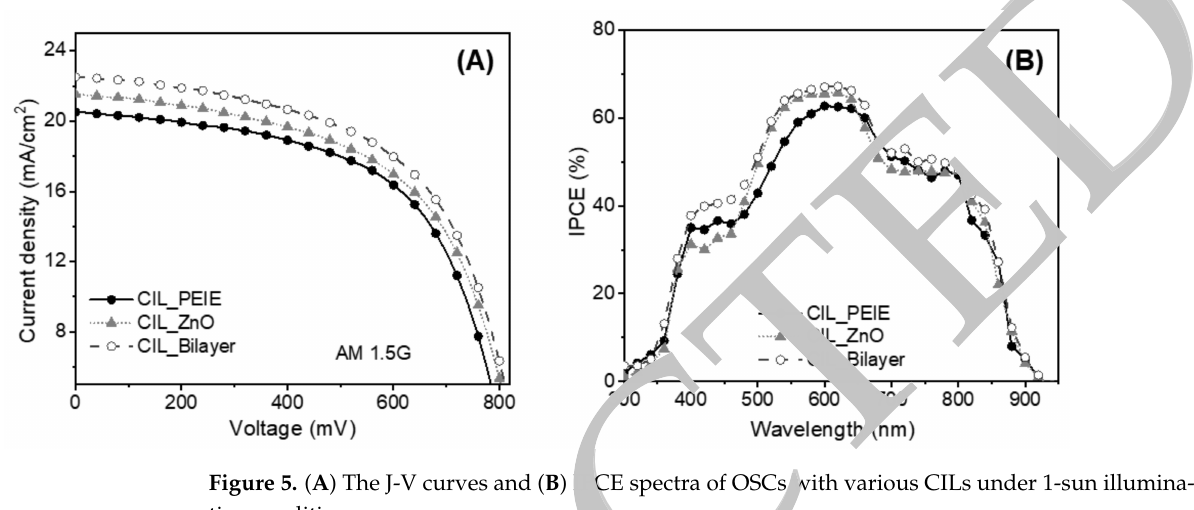
Figure 5. ( A ) The J-V curves and ( B ) IPCE spectra of OSCs with various CILs under 1-sun illumina- tion condition. Table 1. Summary of electrical parameters of OSCs under 1-sun conditions. Values are averaged over 10 devices. The values in brackets are amongst the